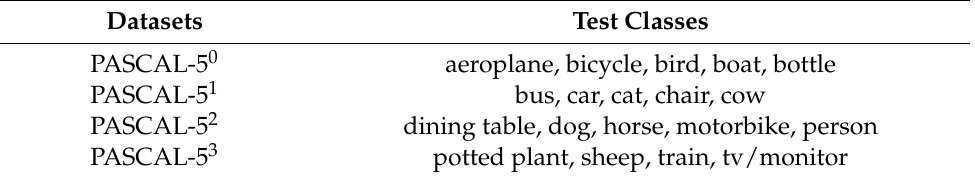
Table 1. Testing classes for a four-fold cross-validation test. The training classes of PASCAL-5 i , i = 0, 1, 2, 3 are disjoint with the testing